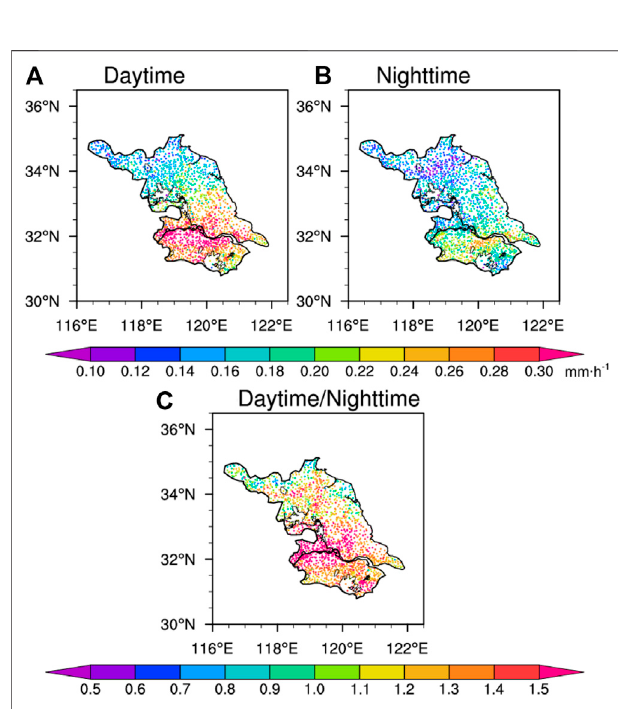
FIGURE 6 | Spatial distributions of daytime (0800-20:00 BJT) PA (A) , nighttime (2000-0800 BJT the next day) PA (B) , and (C) the ratio of daytime PA to nighttime PA in the warm season averaged over 2013 –